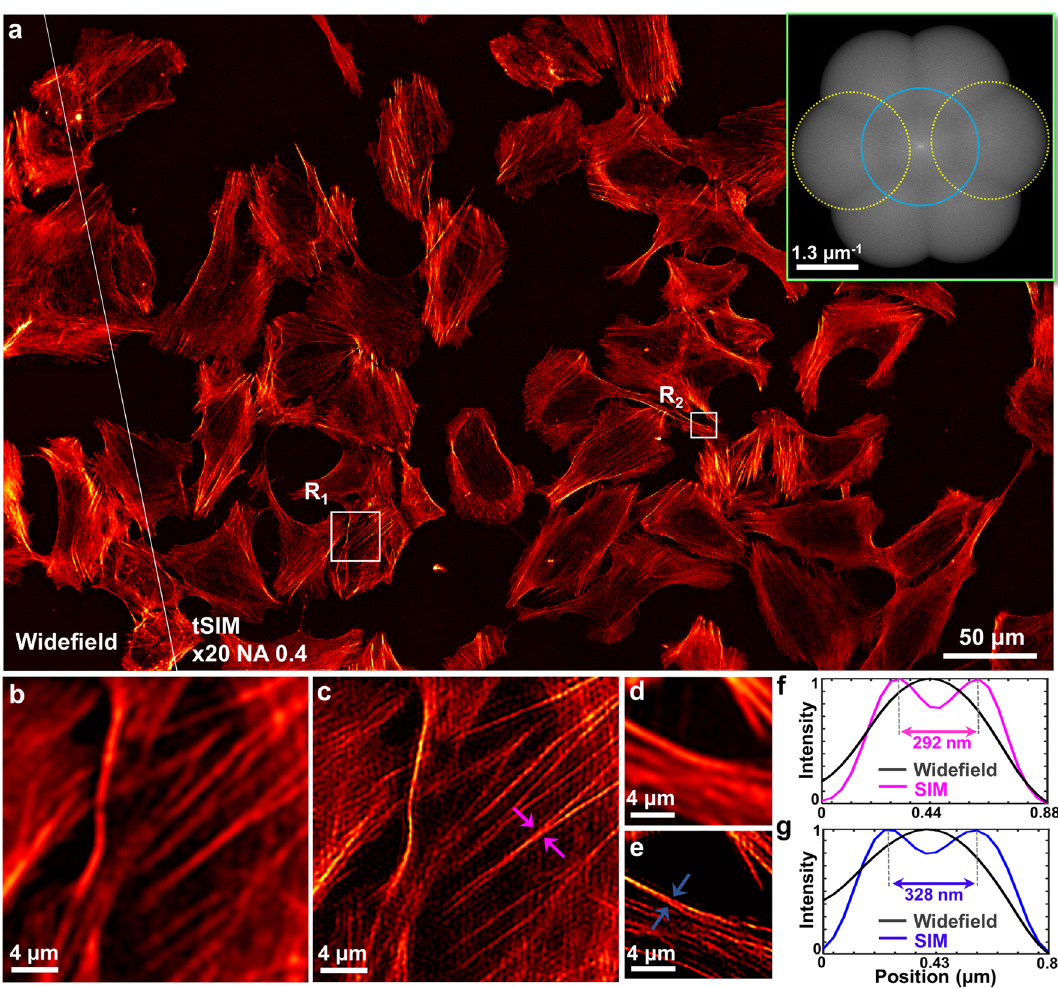
Figure 4. High-frequency tSIM imaging of actin-stained U2OS cell: ( a ) single FOV tSIM reconstruction and diffraction limited image with the excitation/emission wavelengths of 532 nm/560 nm and inset shows spectra of the reconstructed image; ( b , d ) widefield image of R 1 and R 2 regions respectively; ( c , e ) reconstructed image of R 1 and R 2 regions respectively; ( f , g ) intensity line profiles between the magenta and blue